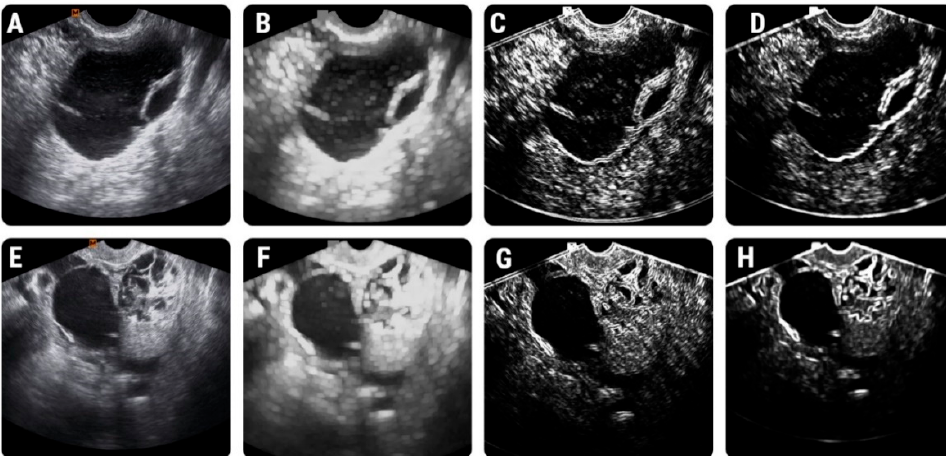
“-” corresponds to no lesion from a histopathological group being misclassified.